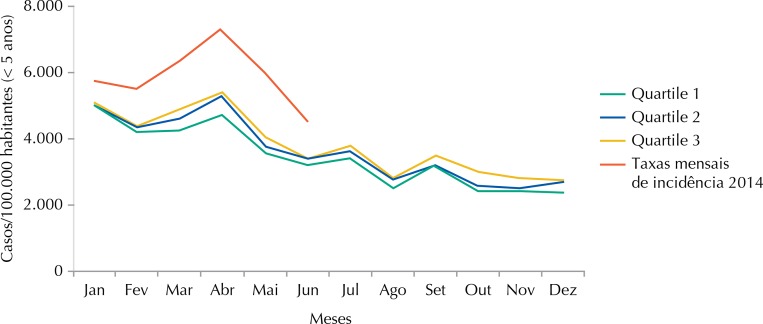
Canal endêmico 2009-2013 (crianças menores de 5 anos) pelo método dos quartis e taxas de incidência mensais registadas em 2014 (crianças menores de 5 anos), Moçambique.